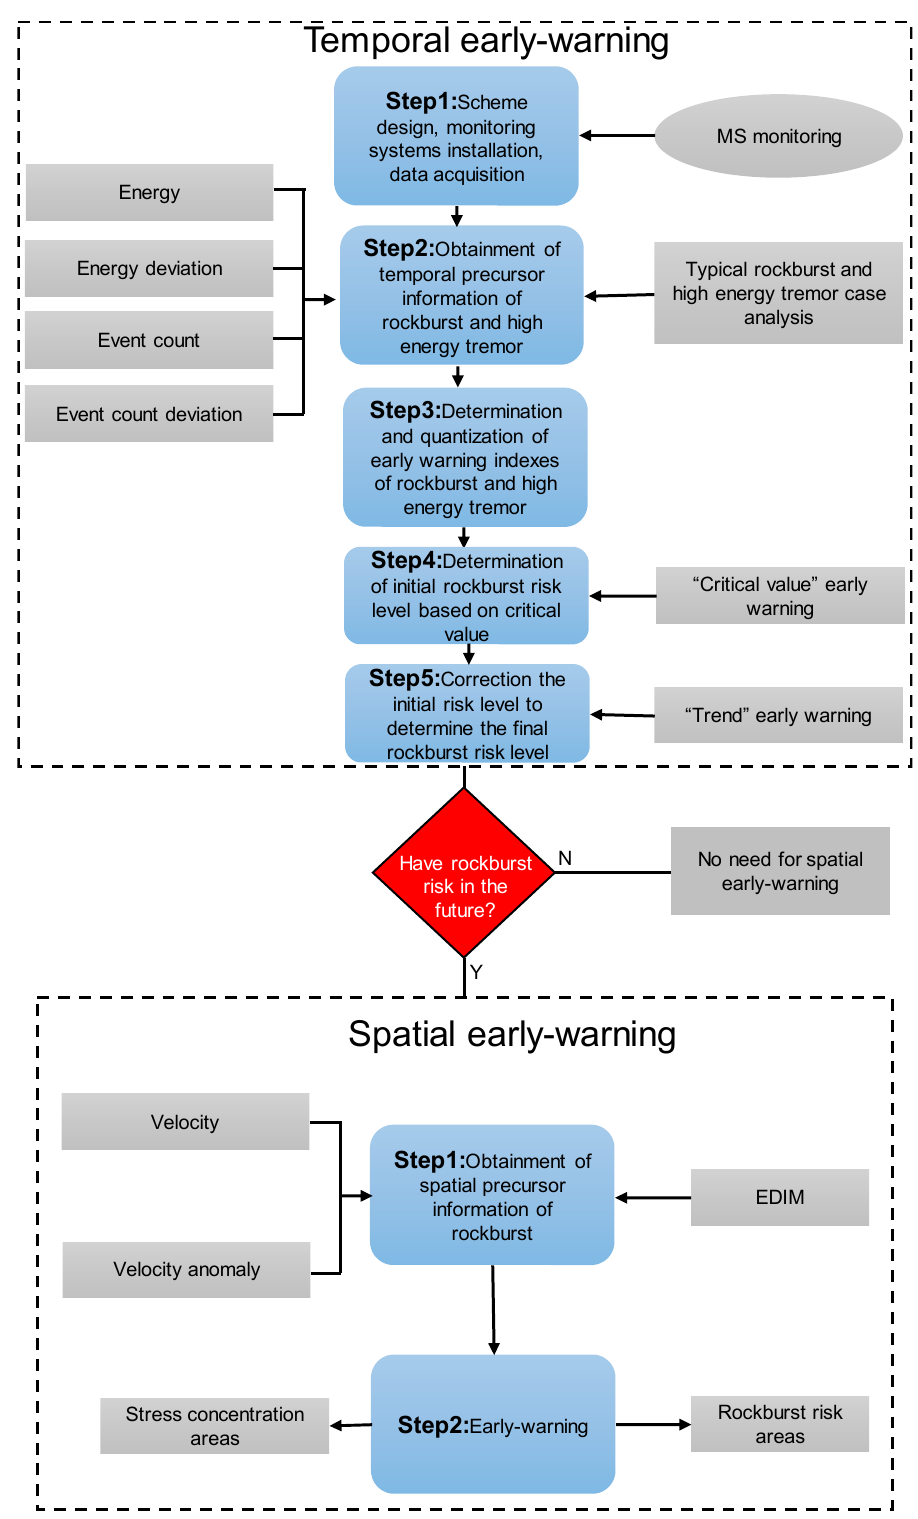
Figure 3. Flowchart of the temporal-spatial comprehensive early warning method to accurately forecast rockburst and risk area. EDIM: energy density index of MS.